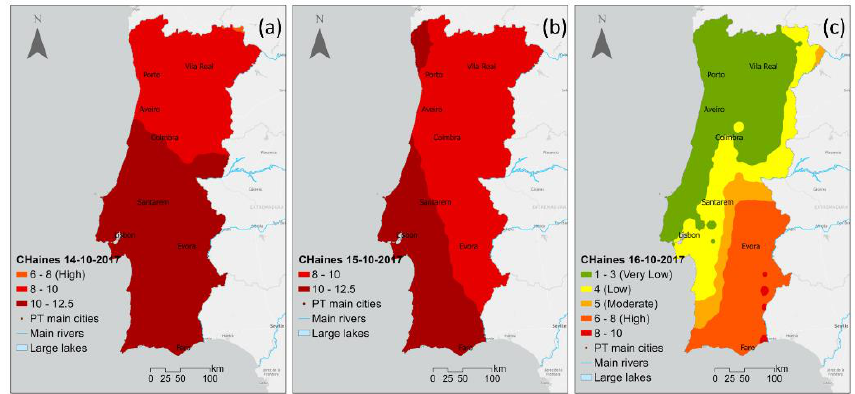
Figure 9. Daily mean values for ( a ) 14, ( b ) 15, and ( c ) 16 October 2017, for CHI.